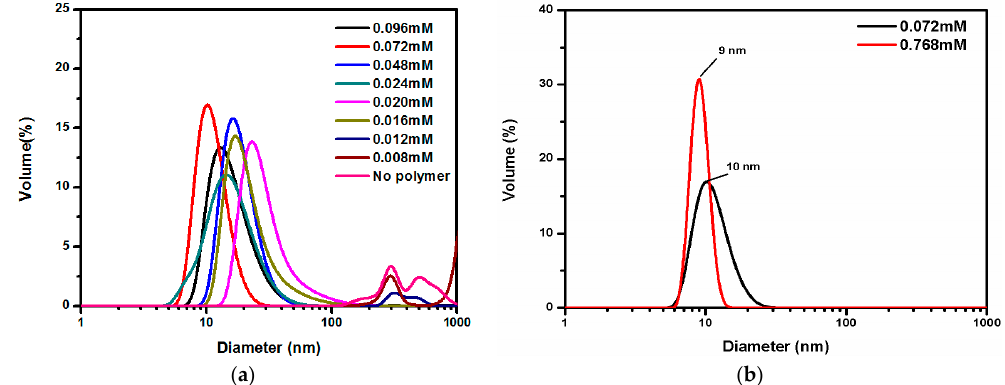
Figure 2. ( a ) Dynamic light scattering (DLS) curves of the MIONs prepared with different concentrations of PTMP-PMAA all lower than 0.768 mM; and ( b ) DLS curves of the MIONs prepared with 0.768 and 0.072 mM concentration of PTMP-PMAA.